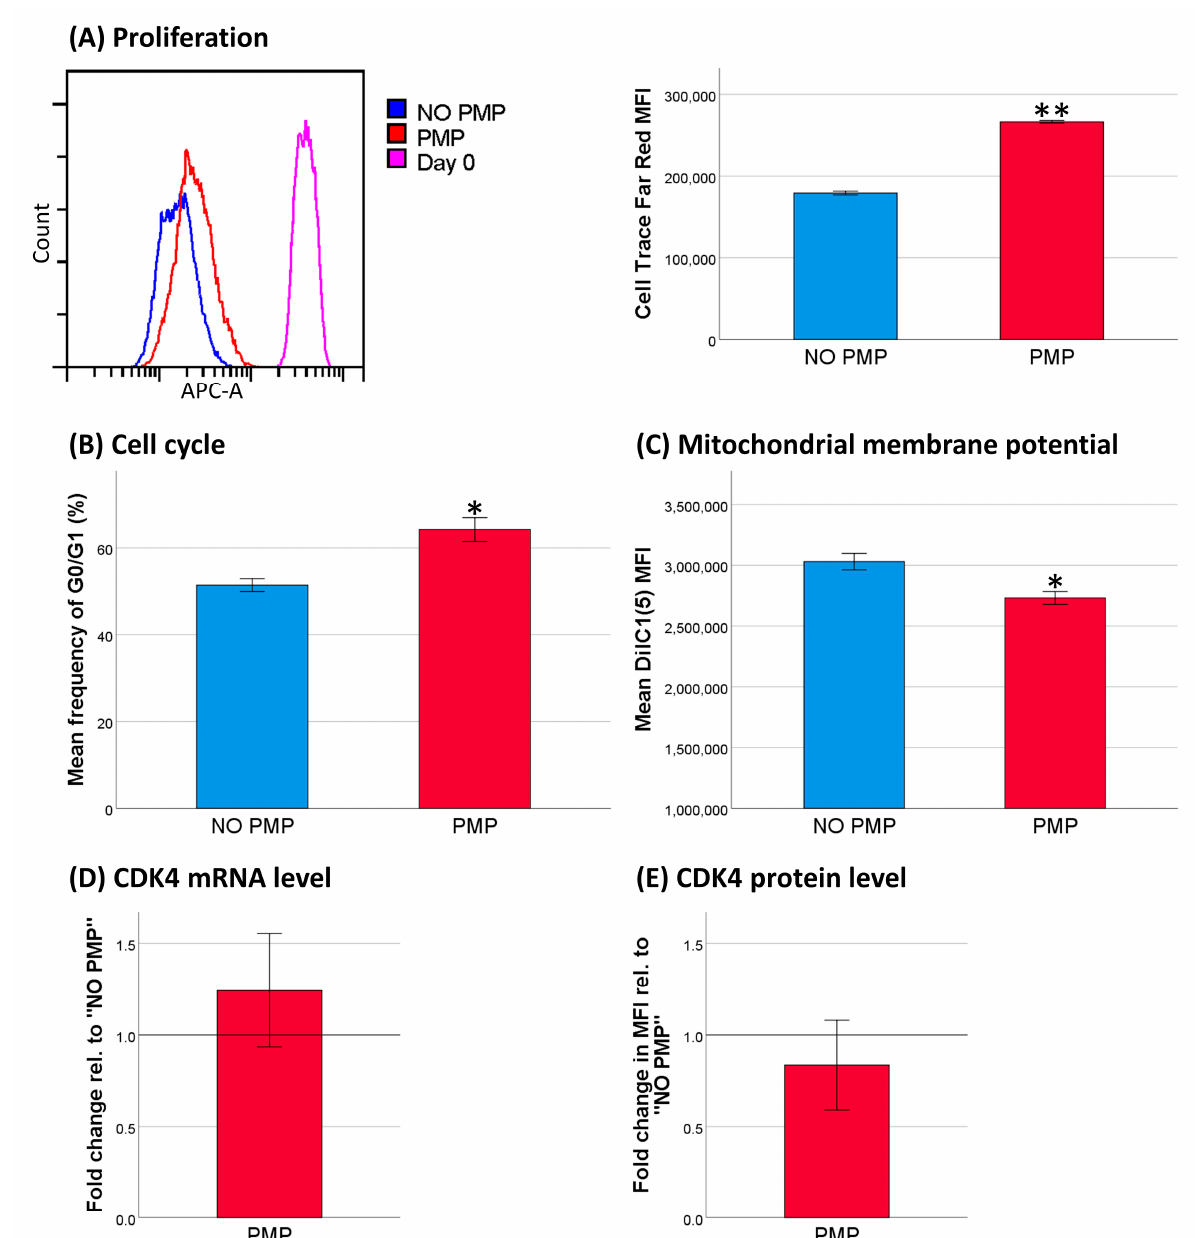
Figure 5. Effects of platelet microparticles (PMPs) on cell activity in THP-1 cells. ( A ) Proliferation analysis by Cell Trace ( n = 5). ( B ) Cell cycle analysis ( n = 3). Cells in G0/G1 cell phase were gated. ( C ) Mitochondrial membrane potential ( n = 4), mean fluorescence intensity (MFI) data. ( D ) CDK4 mRNA levels ( n = 3). ( E ) CDK4 protein levels ( n = 5). ( B – E ) were analyzed after 24 h of PMP co-incubation. mRNA data are calculated as fold change from THP-1 without PMP co-incubation, normalized for ACTB . Protein data are calculated as fold change in MFI from THP-1 without PMP co-incubation. Data were compared using the paired-sample t test for data pairs or the one-sample Wilcoxon signed-rank test for ratios. * p < 0.05. ** p < 0.001.